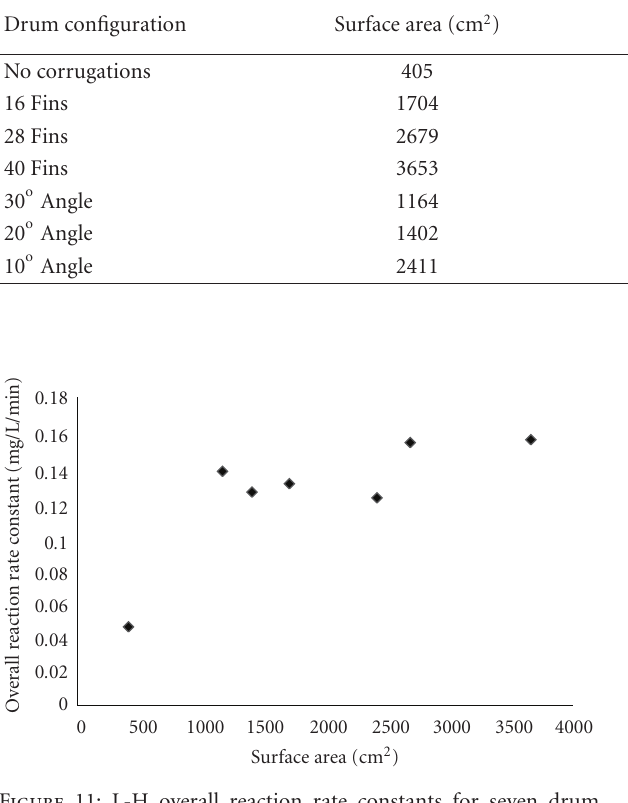
Figure 11: L-H overall reaction rate constants for seven drum configurations (Co = 20 ppm, 15